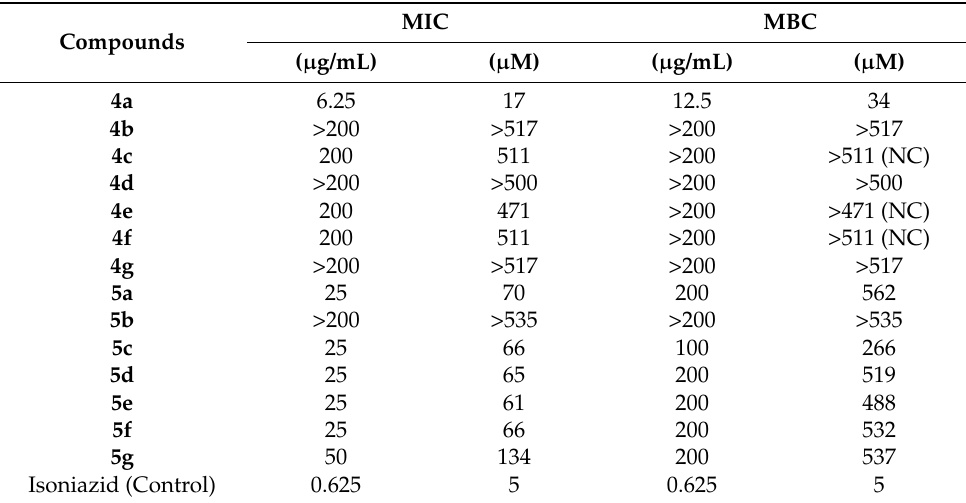
Table 1. In vitro anti-tuberculosis activities of pyrazoline derivatives ( 4a–g and 5a–g ) against My- cobacterium tuberculosis